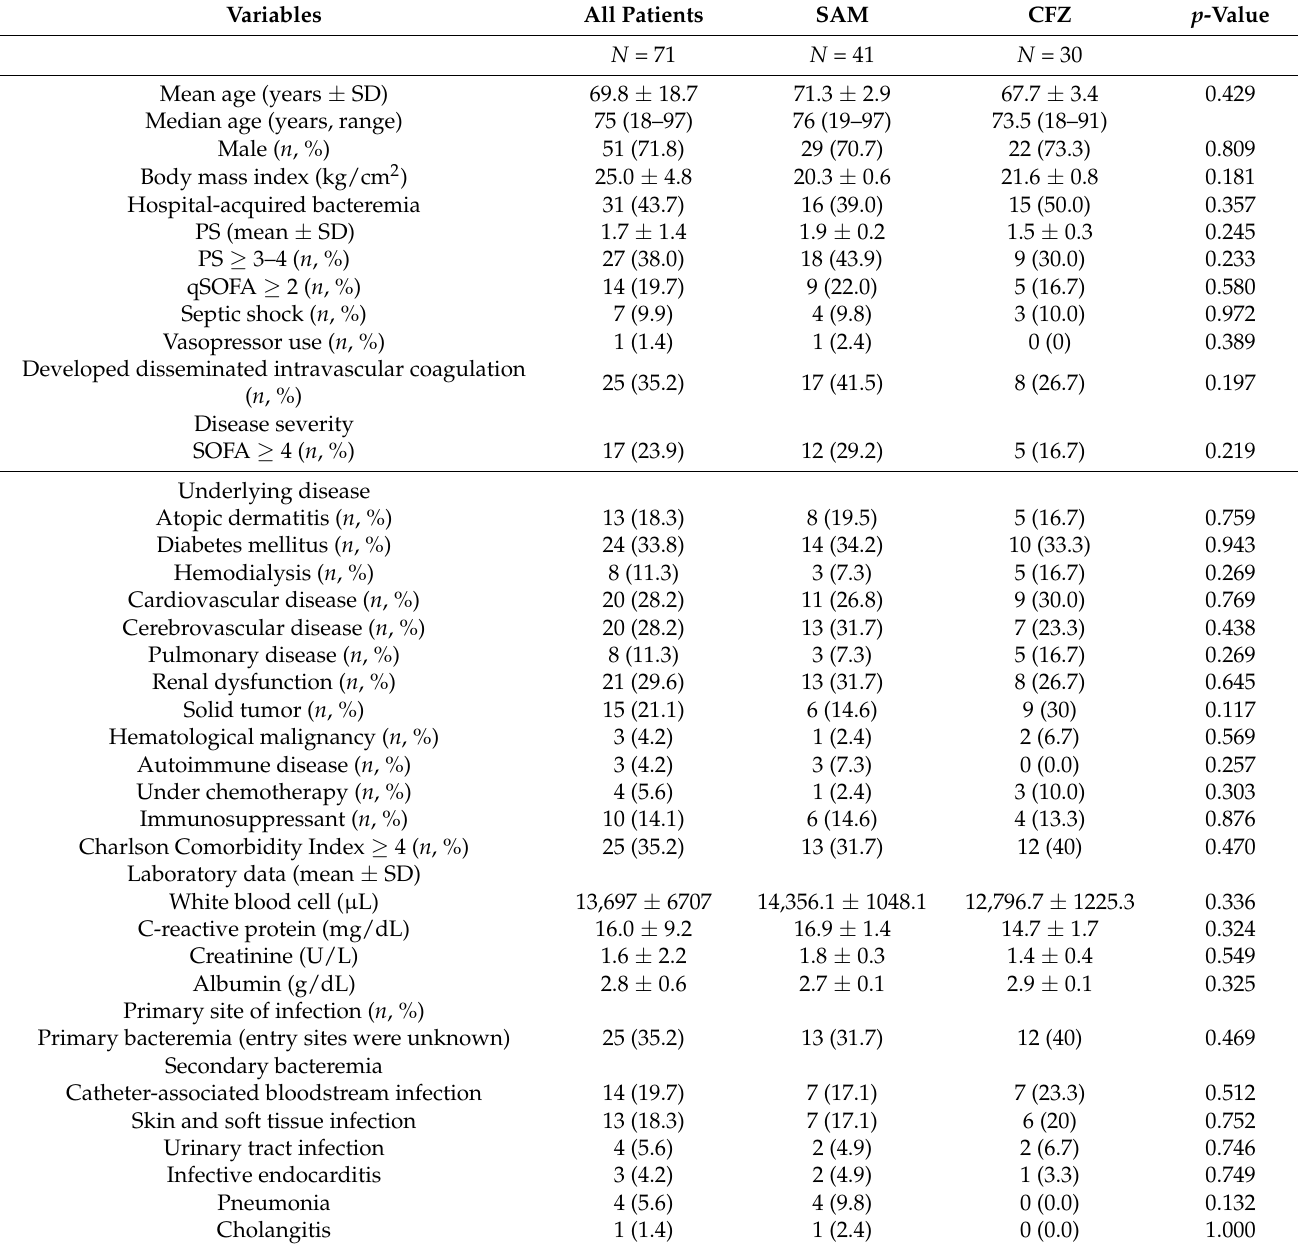
Table 1. Characteristics of the